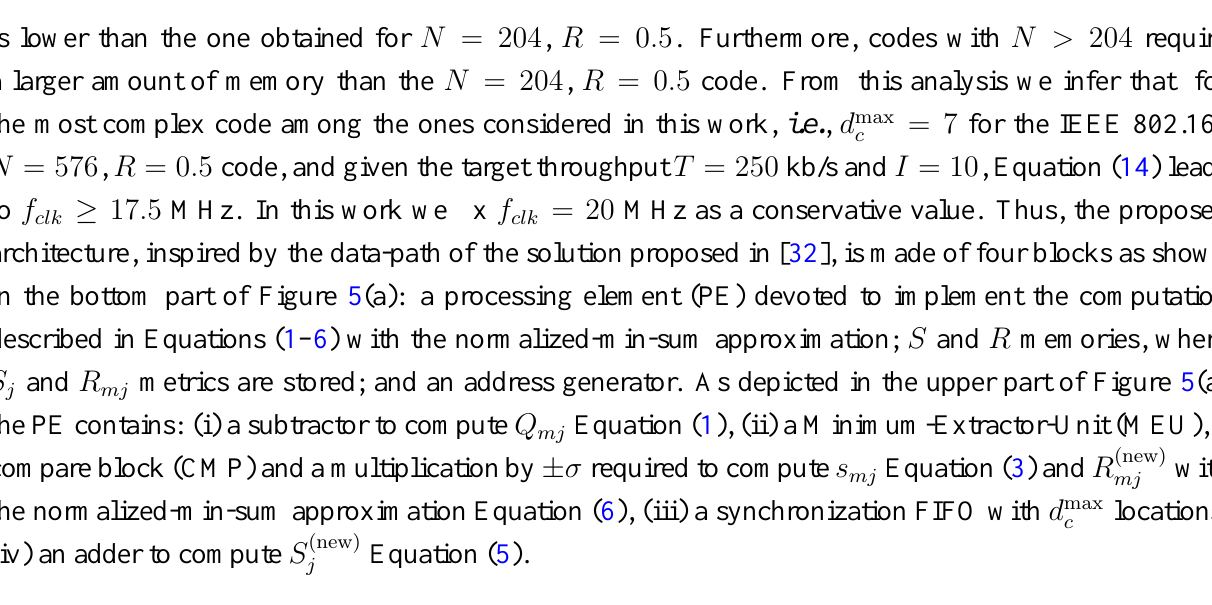
Figure 4. BER performance of the ( N = 204 , R = 0 . 5 ), ( N = 273 , R = 0 . 7 ) and ( N = 495 , R = 0 . 87 ) LDPC